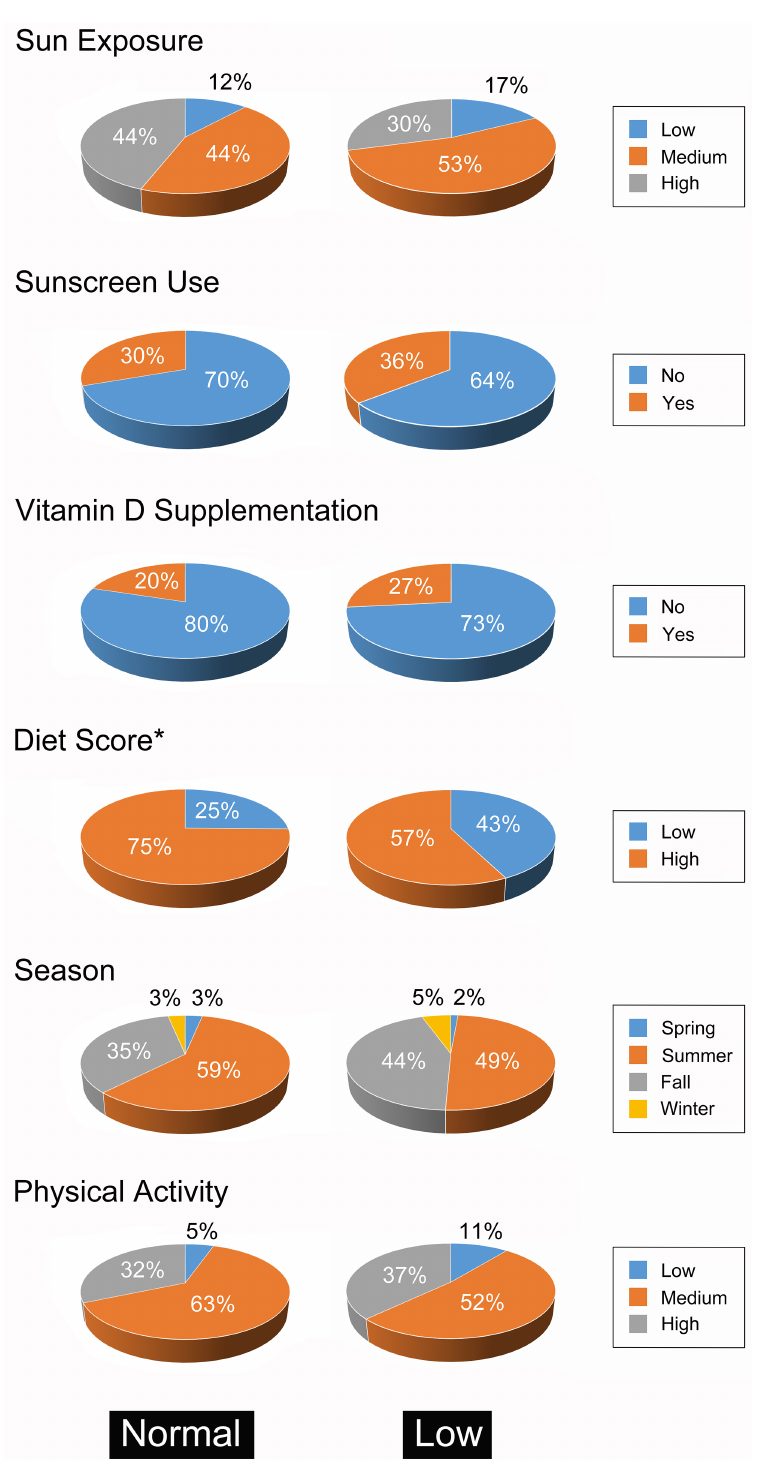
Fig 1. Comparison of factors affecting vitamin D level. Factors affecting vitamin D level betweensubjects (n = 170) with normal(n = 75) and low (n = 95) serum vitamin D level. * p < 0.005betweenthe two groups(Chi-